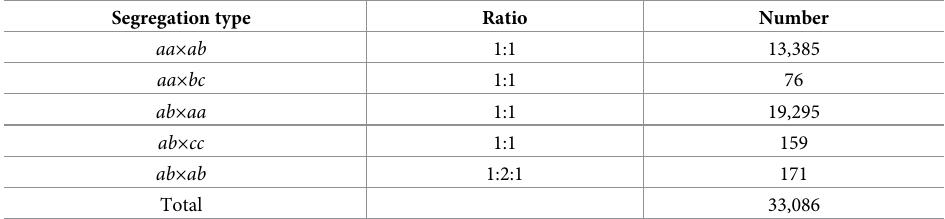
Table 2. Summary of SNPs obtained across the 163 clones based on a randomized complete block